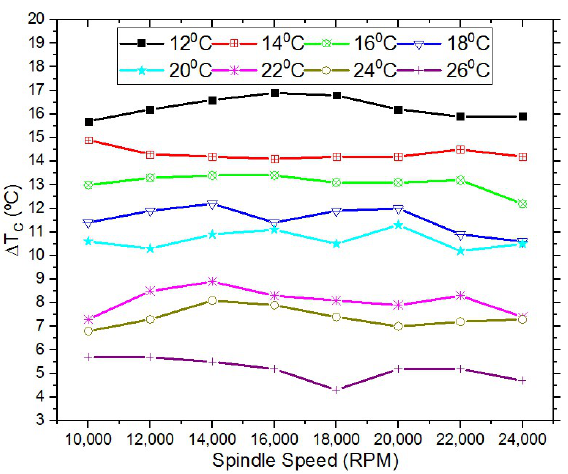
Figure 6. Inlet–outlet coolant temperature difference at a constant flow rate of 5